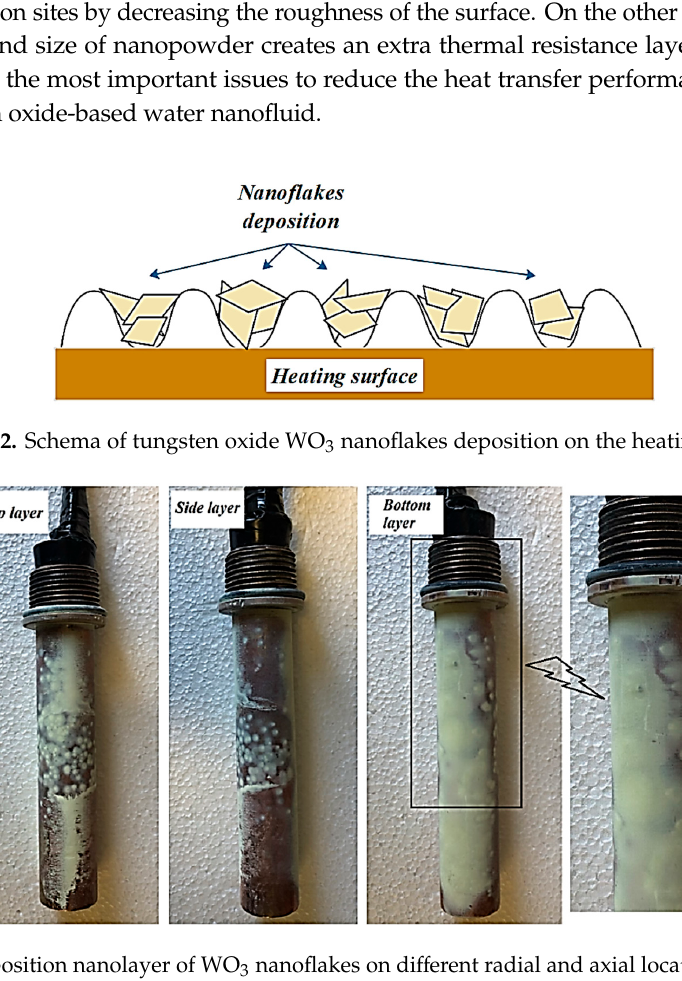
Figure 13. Deposition nanolayer of WO 3 nanoflakes on different radial and axial locations at 0.05% Vol. nanofluid concentration.